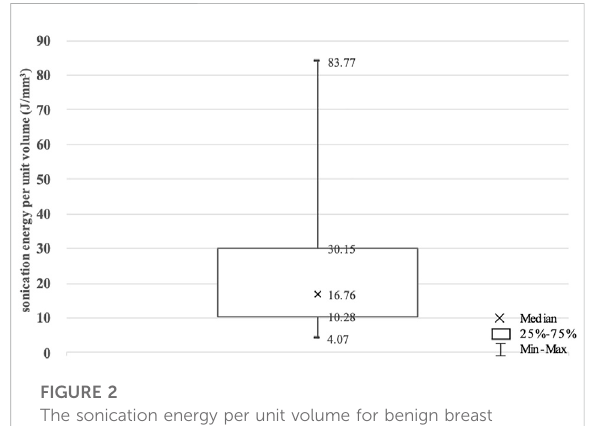
FIGURE 2 The sonication energy per unit volume for benign breast tumors enrolled in this study. Values are expressed as a median, interquartile range (IQR) and minimal and maximal